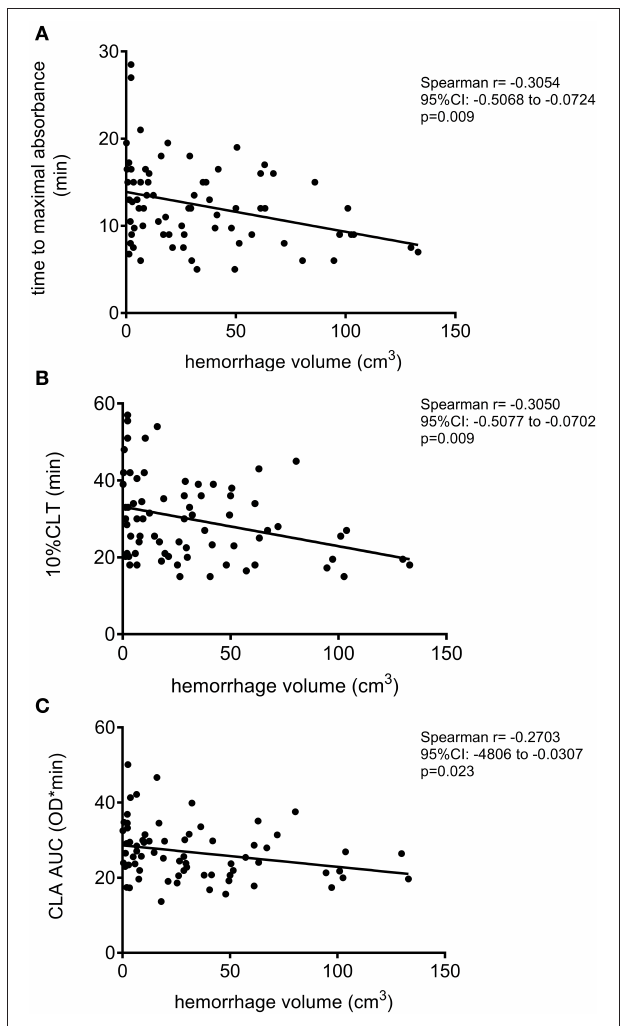
FIGURE 3 | Correlation between the modified clot lysis assay (mCLA) parameters and estimated intracerebral hematoma volume of the ICH patients. mCLA is performed in the presence of cell-free DNA and histones. Correlation between estimated intracerebral hemorrhage volume and time to maximal absorbance parameter (A) , 10% clot lysis time (10%CLT) (B) , and clot lysis assay area under the curve (CLA AUC) (C) are